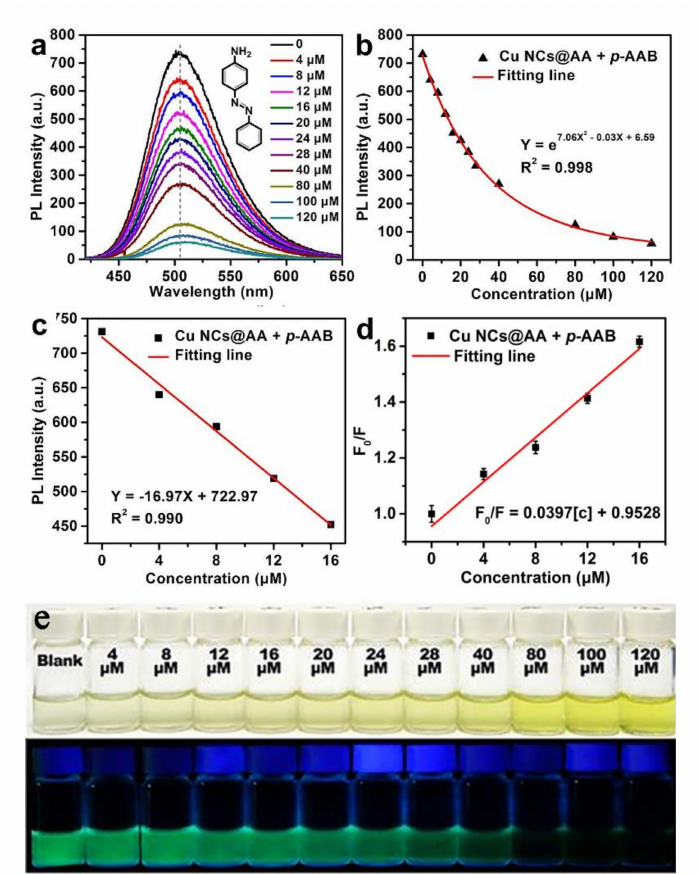
Figure 9. ( a ) Emission spectra of Cu NCs@AA incubated with di ff erent concentrations of p-AAB. ( b ) Nonlinear fitting curve of Cu NCs@AA incubated with di ff erent concentrations of p-AAB. ( c ) The linear standard curve of Cu NCs@AA incubated with di ff erent concentrations of p-AAB in the low range. ( d ) The Stern–Volmer plots of Cu NCs@AA incubated with p-AAB in water. F 0 is the initial PL intensity; F stands for the PL intensity after adding the p-AAB. ( e ) Photos of aqueous Cu NCs@AA incubated with di ff erent concentrations of pAAB in daylight (up) and UV light (down) respectively.